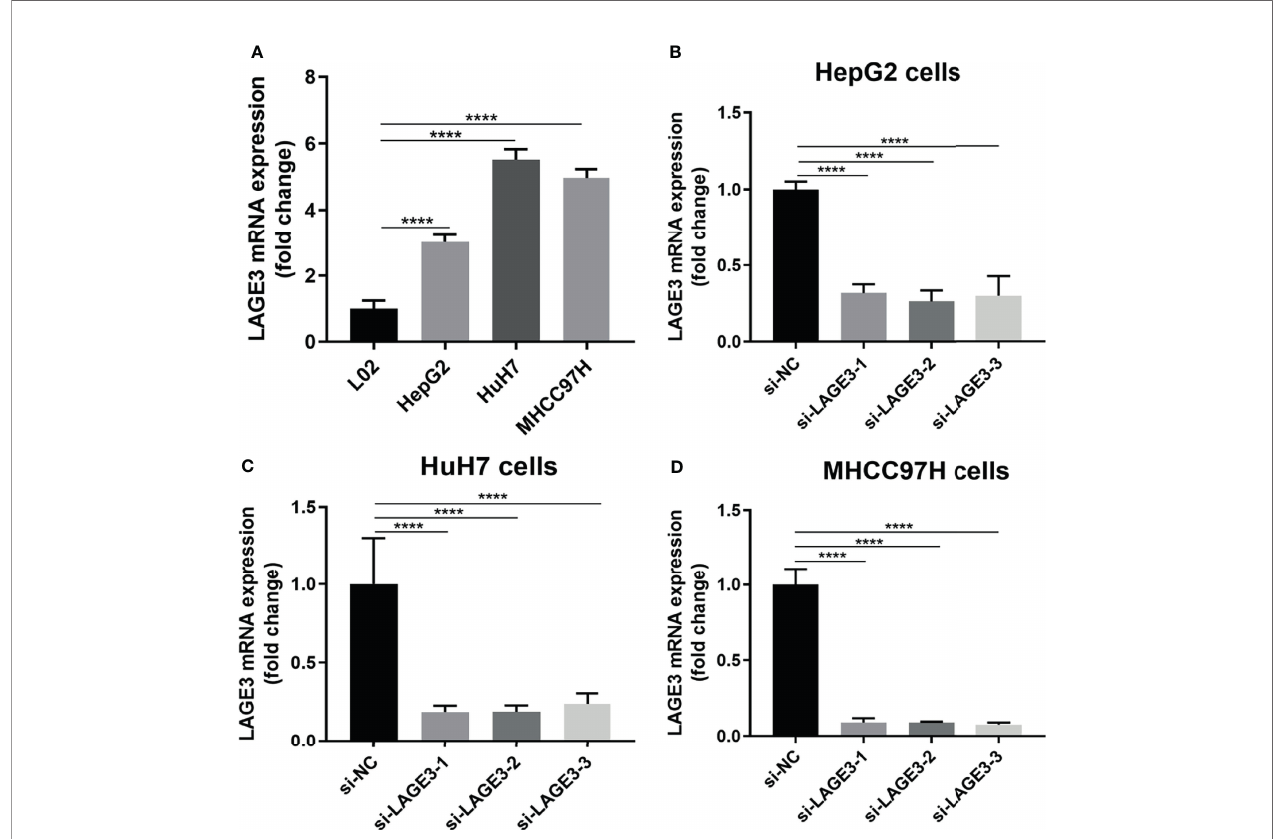
FIGURE 7 | Successful knockdown of LAGE3 expression in HCC cell lines. qRT-PCR was used to detect the expression of LAGE3 mRNA. (A) mRNA expression level of LAGE3 in L02, HepG2, HuH-7, and MHCC97H cells. (B-D) mRNA expression of LAGE3 in HepG2, HuH-7, and MHCC97H cells transfected with si-LAGE3- 1, si-LAGE3-2, si-LAGE3-3 or si-NC. All experiments were conducted in triplicate. Data are expressed as mean ± standard deviation (SD). **** P < 0.0001 compared with L02 or corresponding control